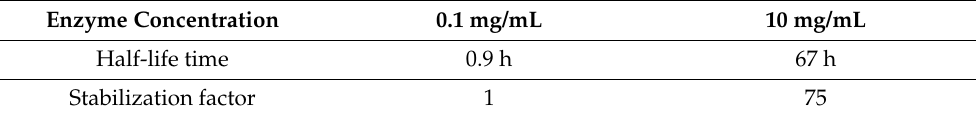
Table 1. Thermal inactivation of diluted and concentrate Lecitase solutions. Enzyme solutions were incubated at pH 7.0 and 60 ◦ C. At different times, aliquots were withdrawn and assayed according to the standard p-NPB assay. Half-life time is the time necessary to decrease the activity by 50%. Stabilization factor is the ratio of half-life times, taking the half-life of the diluted enzyme as the reference.